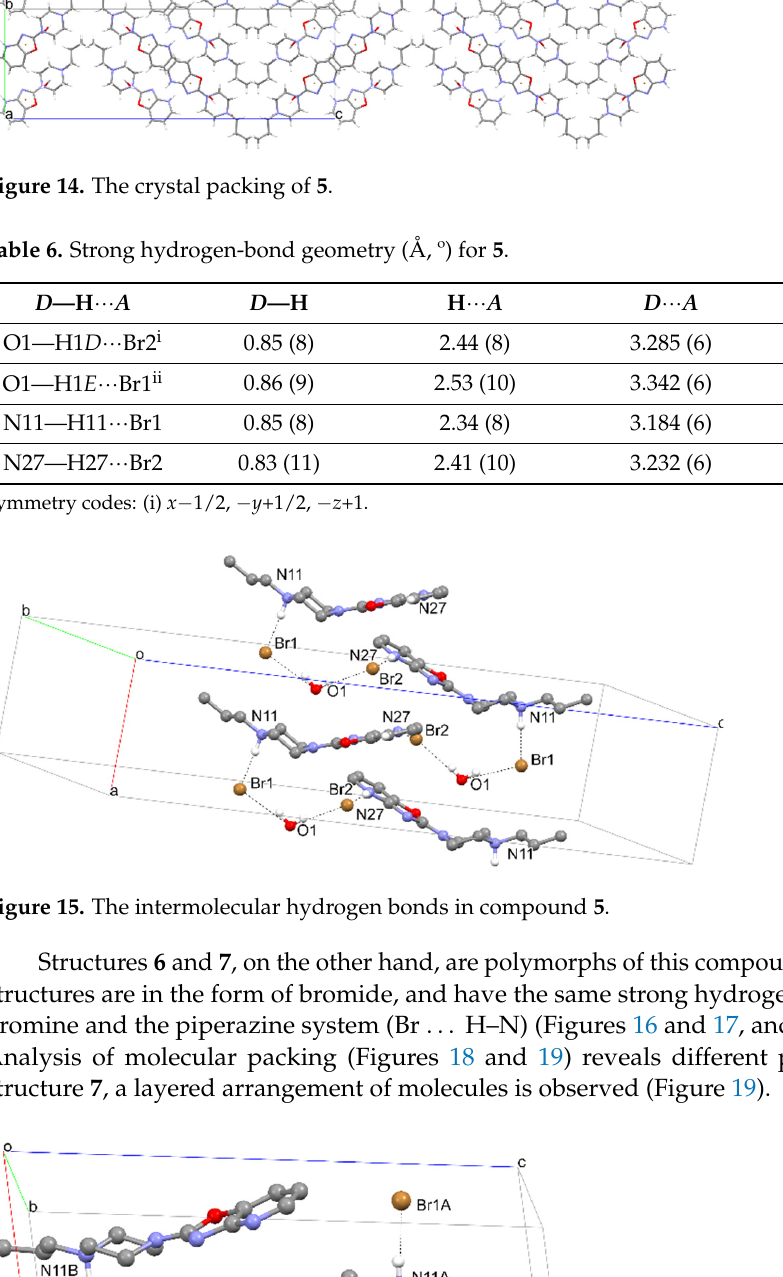
Figure 16. The intermolecular hydrogen bonds in compound 6 .